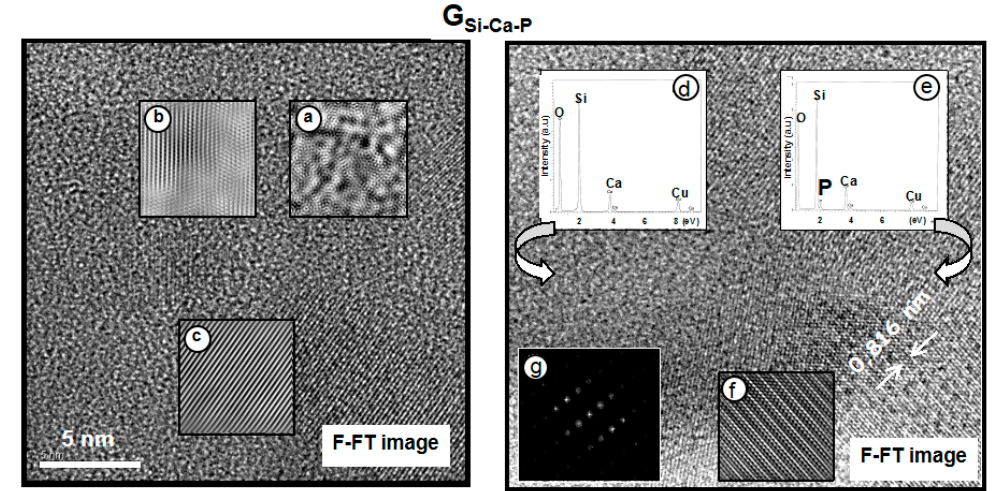
Figure 5. Left : Fourier ‐ Filtered HRTEM of G Si–Ca–P . ( a ) The magnification of an amorphous region and of two crystalline areas ( b ) and ( c ). Right : ( d ) EDX spectra of an amorphous region, depleted in P, and of a crystalline region ( e ), rich in P. ( f ) Magnification of the right lower corner of a crystalline region and its corresponding FT pattern ( g ).